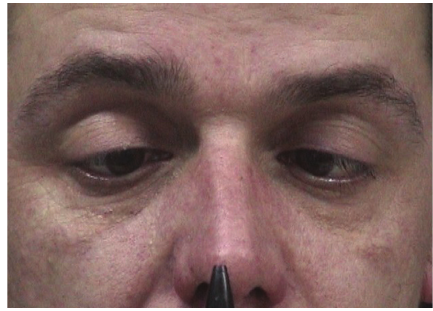
Figure 3: Absent pupil response to accommodation of both eyes and normal convergence.